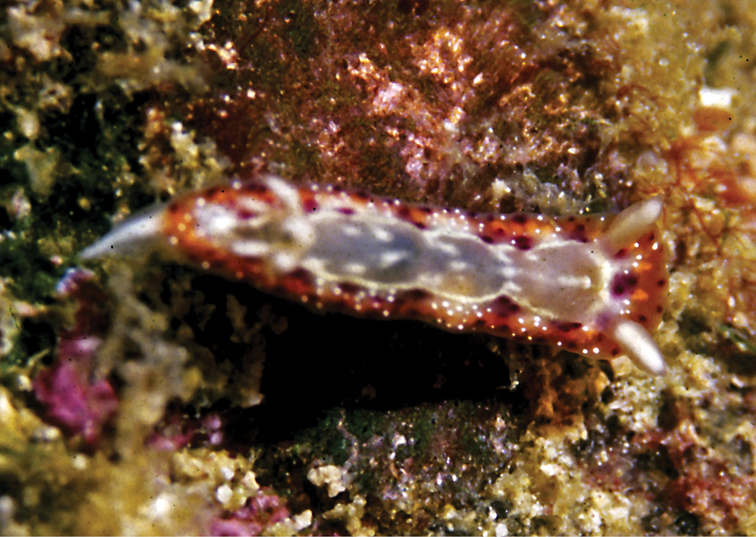
Chromodoris decora, 10 mm, Maldives, photo: RC Anderson.